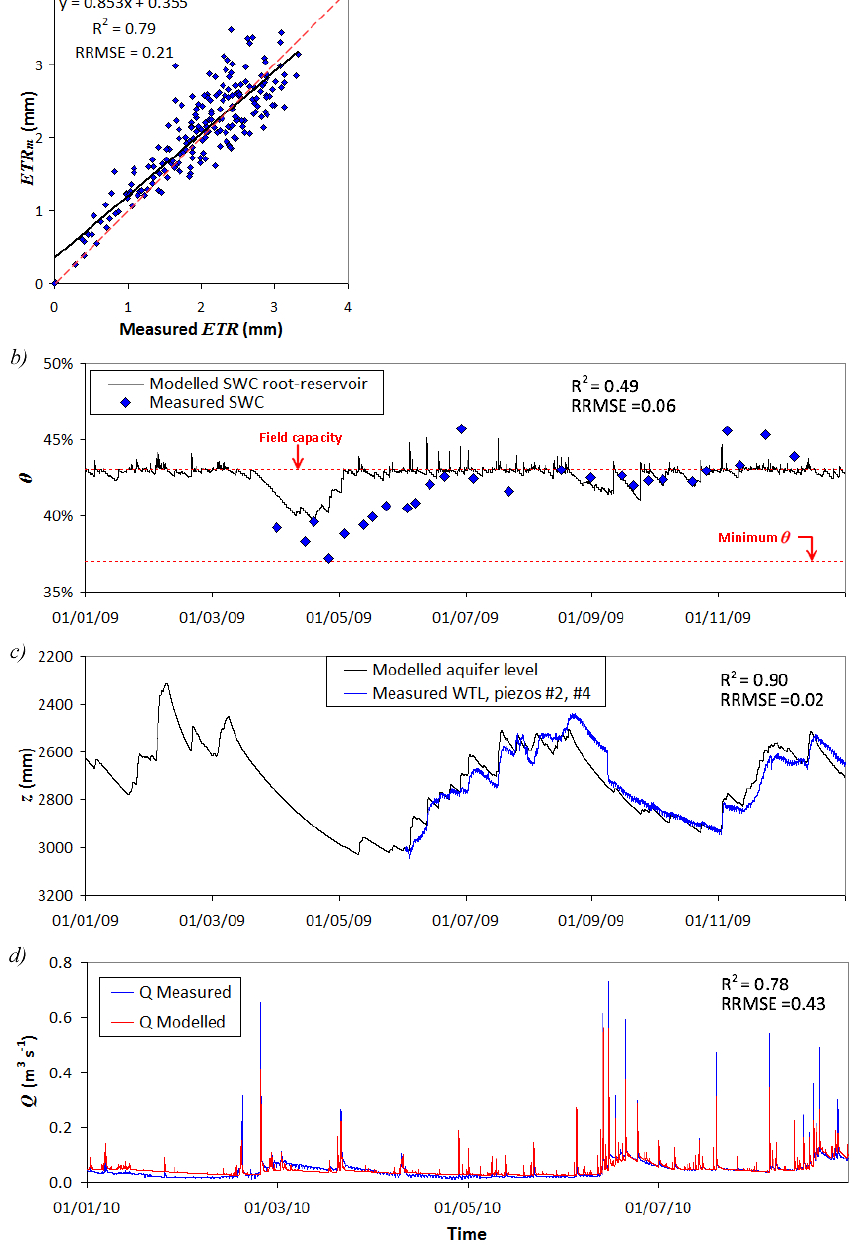
Fig. 8. Validation of: (a) daily evapotranspiration ETR m , (b) soil water content θ at the 1.6m root-reservoir, (c) water table level z and (d) streamflow Q for eight months of 2010. ( R 2 : determination coefficient, RRMSE: relative root mean squared error).